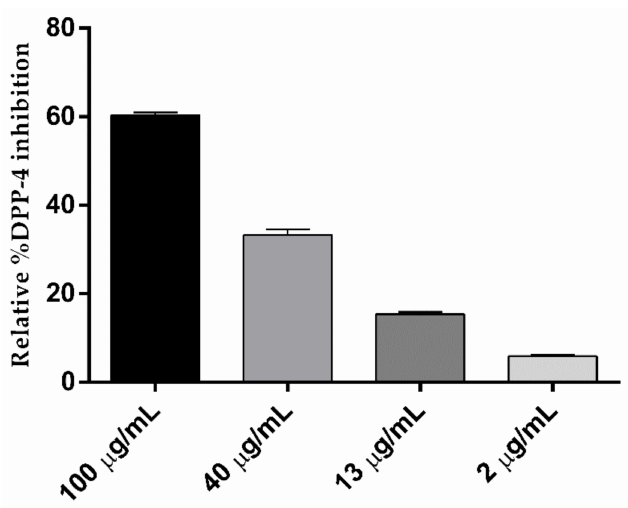
Figure 3. Percent of DPP-4 inhibition of ultrasonic-assisted extraction of garlic in aqueous methanol. Data are expressed as mean ± S.D.